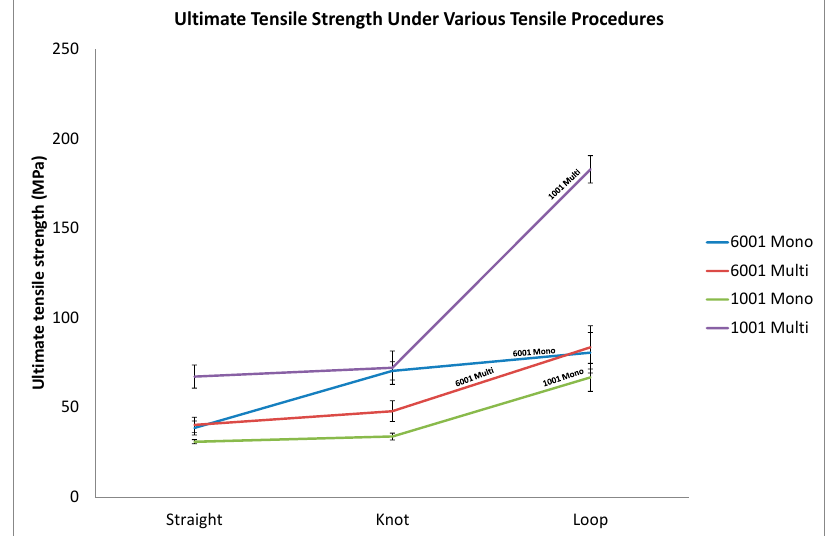
Figure 11. Ultimate tensile strength from tensile analysis of the multifilament and monofilament fibres. Table 6. Average ultimate tensile strength.